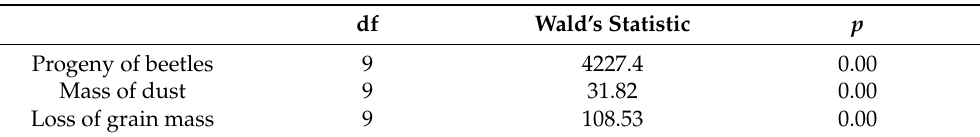
Table 1. Results of the generalised linear model (GLM) analysis for the number of S. granarius offspring specimens, the mass of produced dust and loss of the mass of kernels of the analysed wheat cultivars.